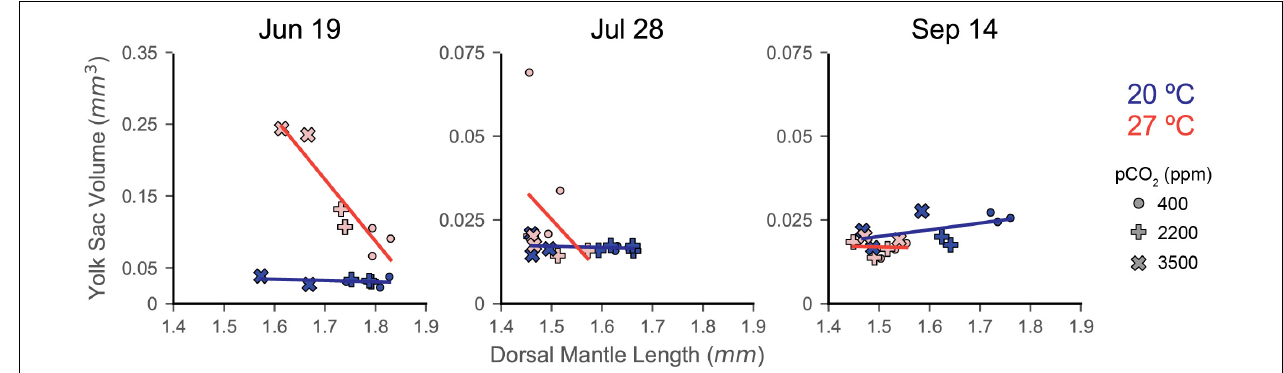
FIGURE 4 | Response of individual egg capsules within a clutch to acidification and warming as indicated by comparing YV ( y -axis; note shift in scale from June 19 to July 28) with DML ( x -axis). Trials are indicated by title. Symbol shape indicates acidification treatment (circle = 400 ppm, plus sign = 2200 ppm, X = 3500 ppm), while color denotes temperature (blue/dark = 20 ◦ C; red/light = 27 ◦ C). Symbols represent the means for a single egg capsule (one cup within the experimental system). No error bars are depicted for visual clarity. Trend lines are regressions of each temperature treatment, but are only presented as visual